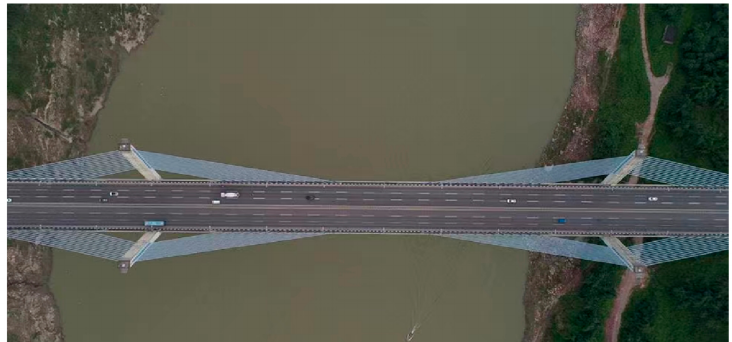
Figure 2. Overhead image of the